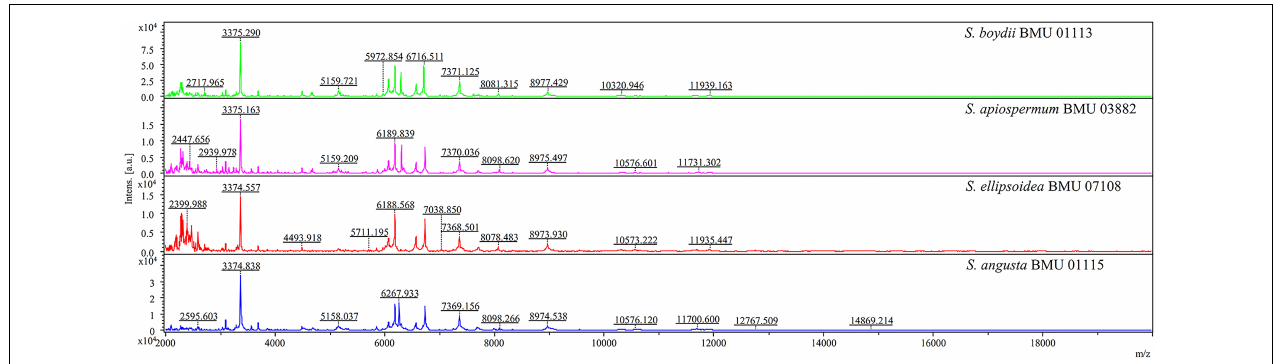
FIGURE 1 | Matrix-assisted laser desorption ionization-time-of-flight mass spectra (m/z 2,000 to 20,000) of Scedosporium species.